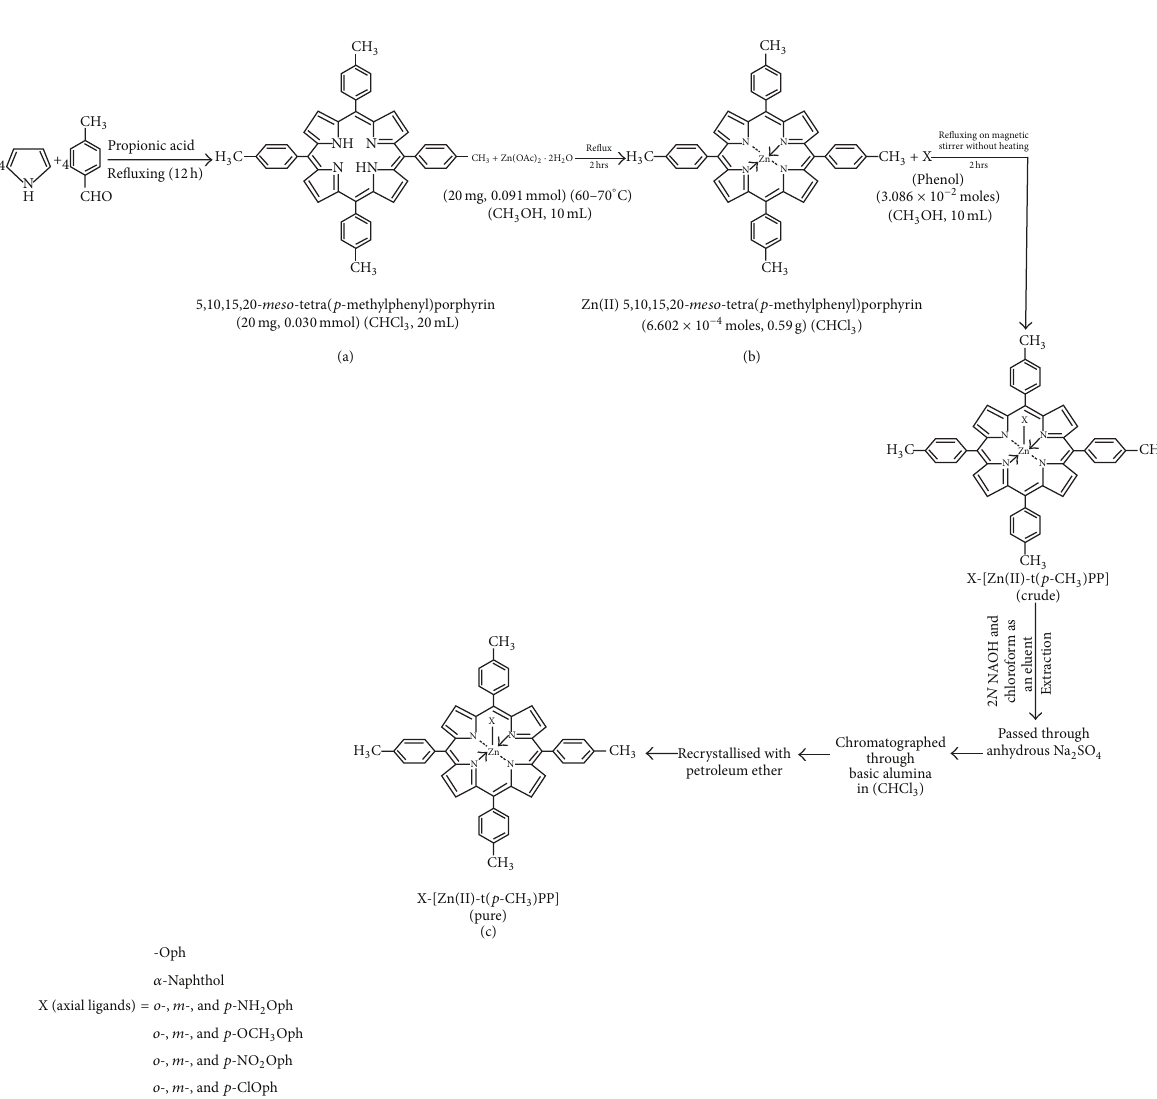
Recrystallised with petroleum